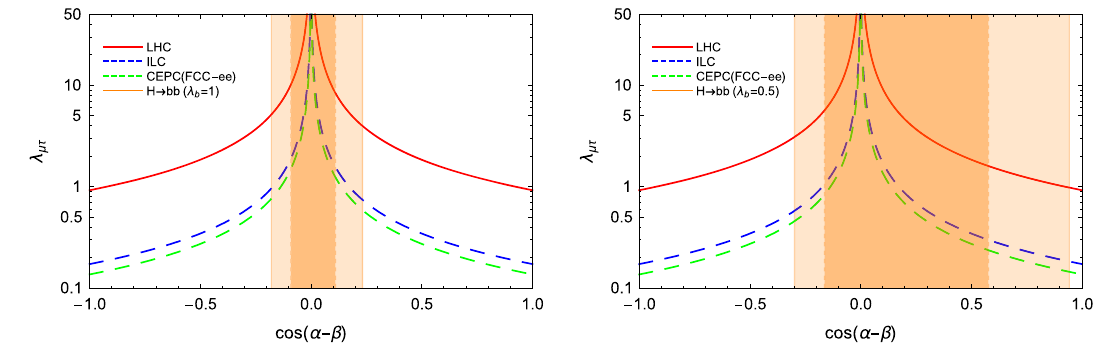
Fig. 2 The red (solid), blue (dashed) and green (dashed) curves rep- resent the constraints at 95% CL on the cos (α − β) - λ μτ plain (the regions above the curves are excluded) set by the the LHC [64], the ILC and the CEPC (FCC-ee) upper bounds on B ( H → μ ± τ ∓ ) , respec-